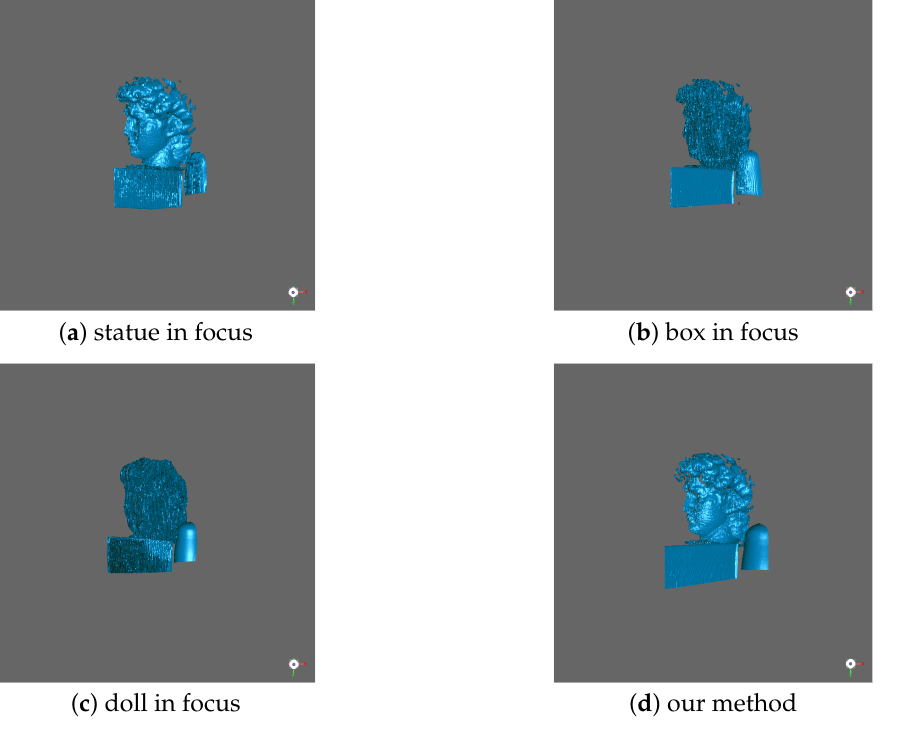
Figure 8. Comparison of measurement results. The scene includes three objects of different shapes and materials. ( a ) The statue in-focus; ( b ) the box in-focus; ( c ) the doll is in-focus; ( d ): our method.